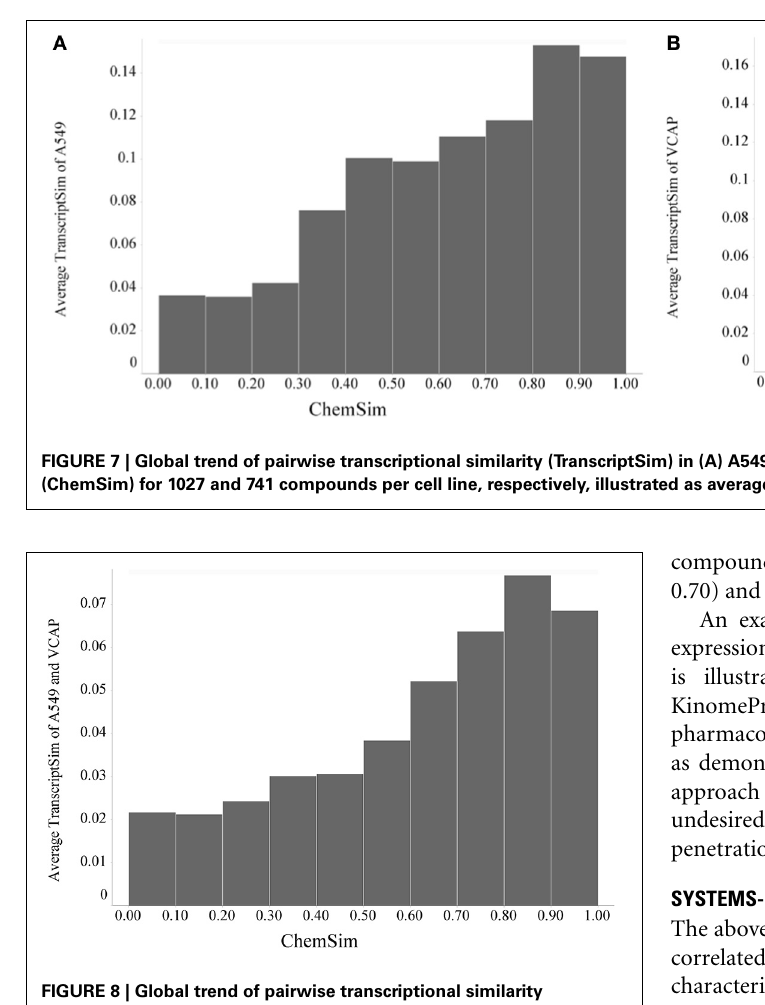
FIGURE 8 | Global trend of pairwise transcriptional similarity (TranscriptSim) across A549 and VCAP cells and chemical structure similarities (ChemSim) for 1027 and 741 compounds per cell line, respectively, illustrated as average TranscriptSim values by ChemSim